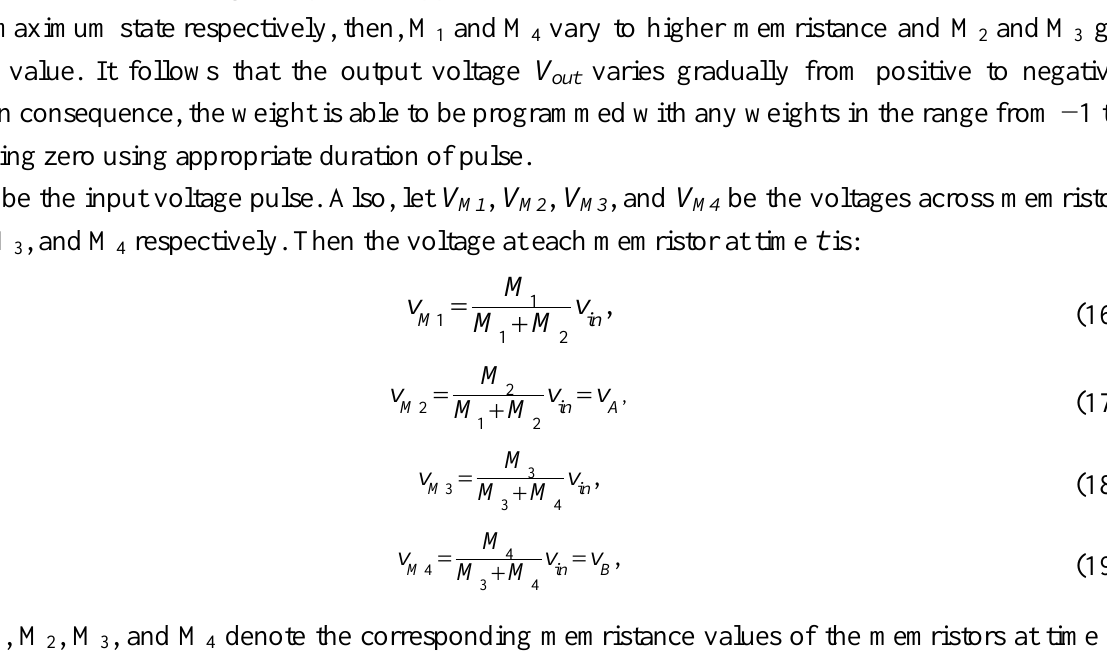
Figure 5. Memristor based synaptic circuit in [24]. It is assumed that M decrementally biased memristor while M